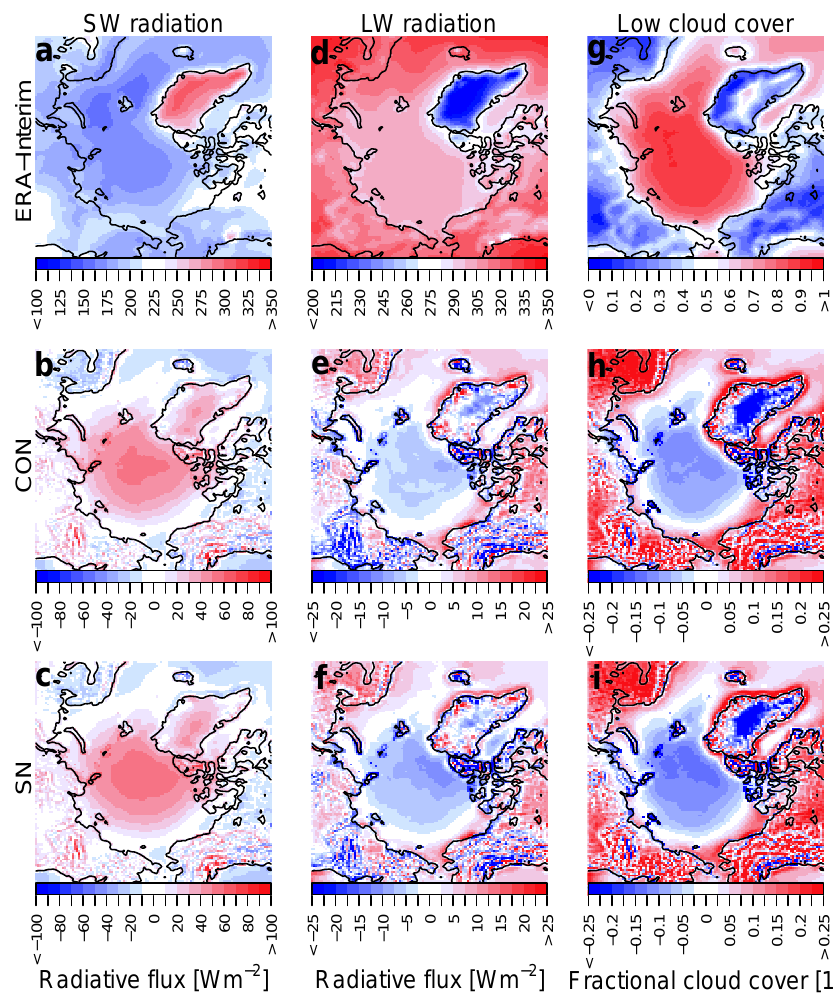
Fig. 6. JJA downward surface shortwave (a–c) and longwave (d–f) radiation, as well as low cloud cover, defined as the fractional cloud cover below 650 hPa (g–i). The top row shows the ERA-Interim values, the middle row the bias of CON with respect to ERA-Interim, and likewise for SN in the bottom row.